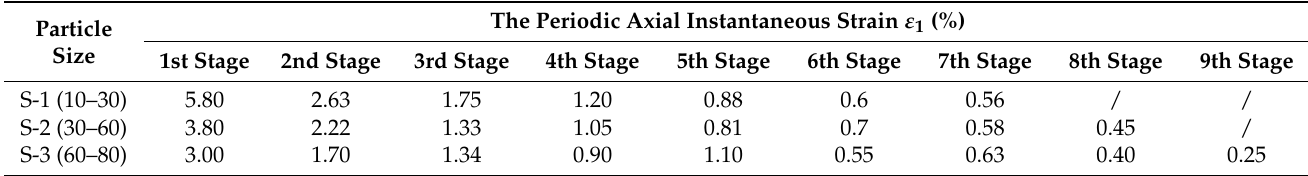
Table 3. The periodic creep strain of crushed mudstone samples at each loading stage. Particle Size